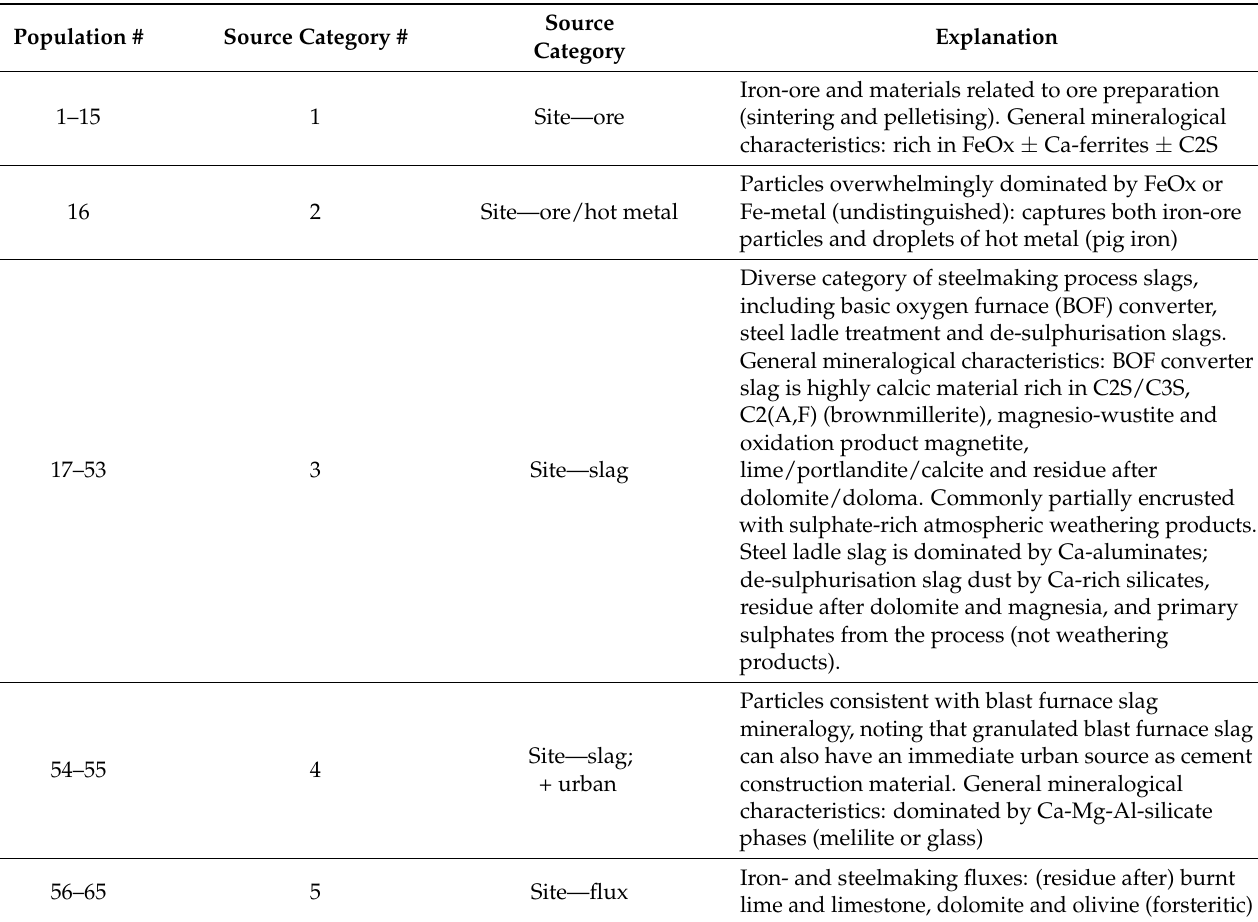
Table 1. Defined grain populations ordered and grouped by interpretive category. C2S = dicalcium silicate; C3S = tricalcium silicate; C2(A,F) = brownmillerite; qz = quartz; fsp =